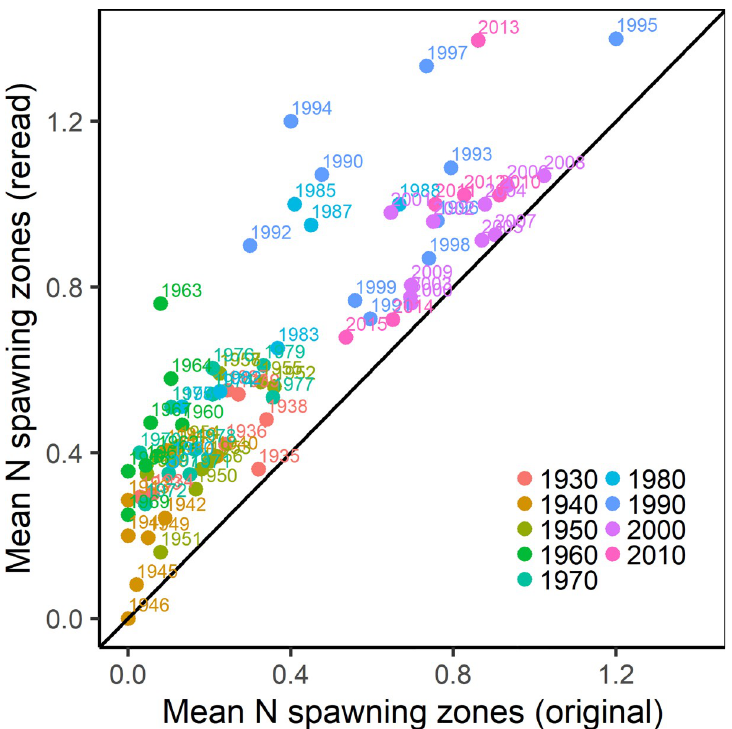
Fig 11. Comparison of number of spawning zones between readers. Yearly mean number of spawning zones in fish of age 8 calculated from the original and the reinterpreted subsample, decades coded by color.